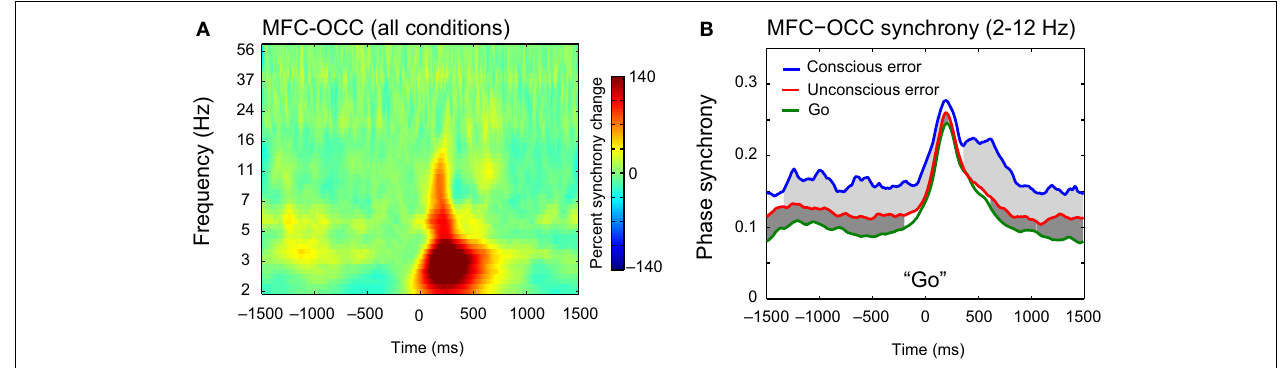
FIGURE 2 | Oscillatory phase synchrony between prefrontal and occipital cortices was signifi cantly enhanced following unconscious and conscious errors. (A) Time-frequency plot of oscillatory phase synchrony averaged across all conditions demonstrates a “burst” of synchrony between a pool of medial frontal electrodes (MFC) and a pool of occipital electrodes (OCC) from around 2–12 Hz following the onset of the Go stimulus (data are converted to percent change from a − 300 to − 100 ms baseline at each frequency). (B) Oscillatory phase synchrony from 2–12 Hz plotted separately